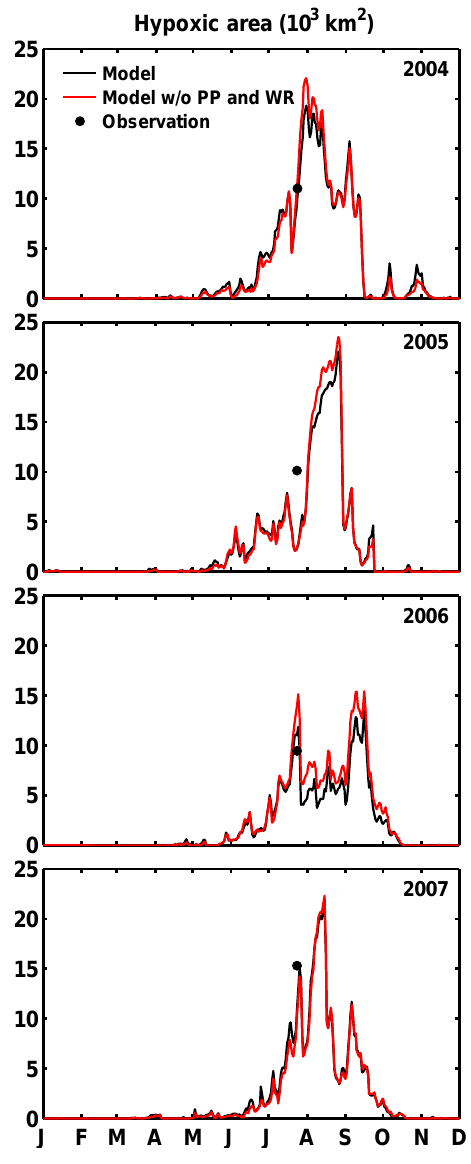
Figure 10. Time series of simulated hypoxic extent for the full model (black line) and the model without biological processes in the water column (red line). Also shown is the observed hypoxic extent in late July (black dots). The observed hypoxic extent was estimated by linearly interpolating the observed oxygen concentra- tions onto the model grid and then calculating the area with oxygen concentrations below the hypoxic threshold (Fennel et al.,